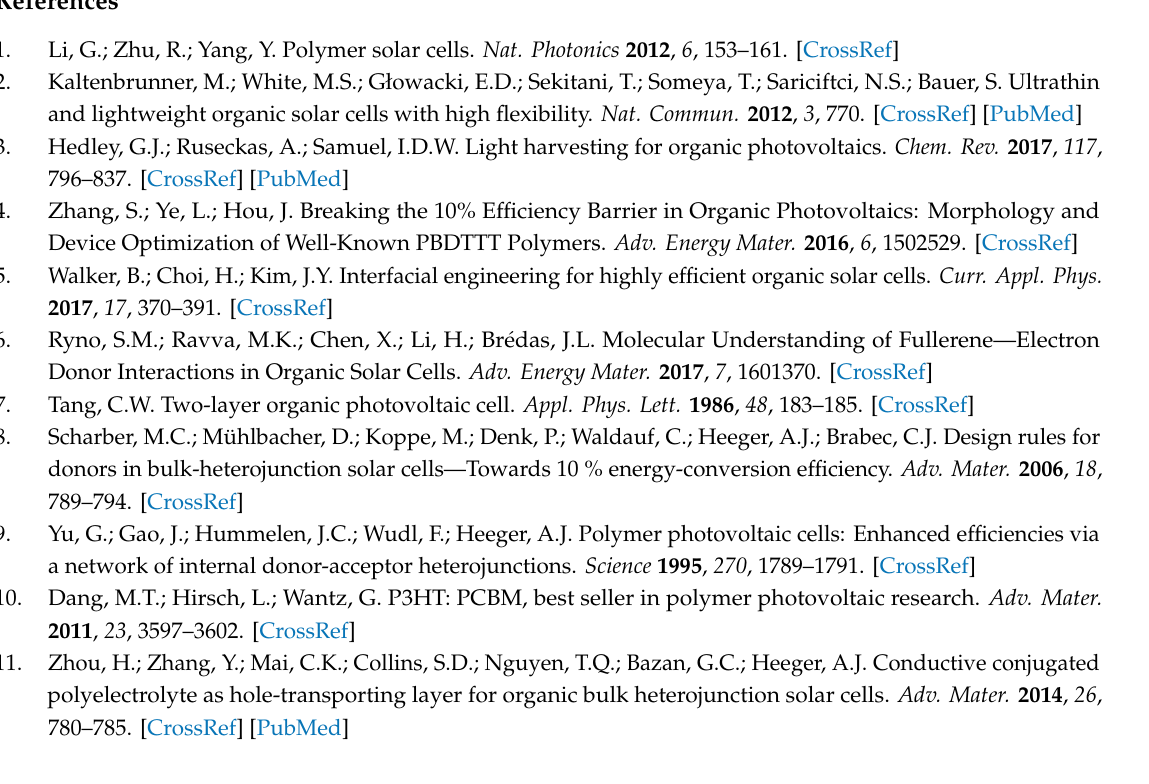
Figure S1: EQE characterization of inverted P3HT:PC 61 BM solar cells with various organic / inorganic hybrid composites. Figure S2: Surface topographic AFM images (size: 2 µ m × 2 µ m). Figure S3: Photos of water droplets on the surfaces. Figure S4: J-V characteristics under illumination of inverted P3HT:PC 61 BM solar cells with PEIE. Table S1: Device characteristics of inverted P3HT:PC 61 BM solar cells with